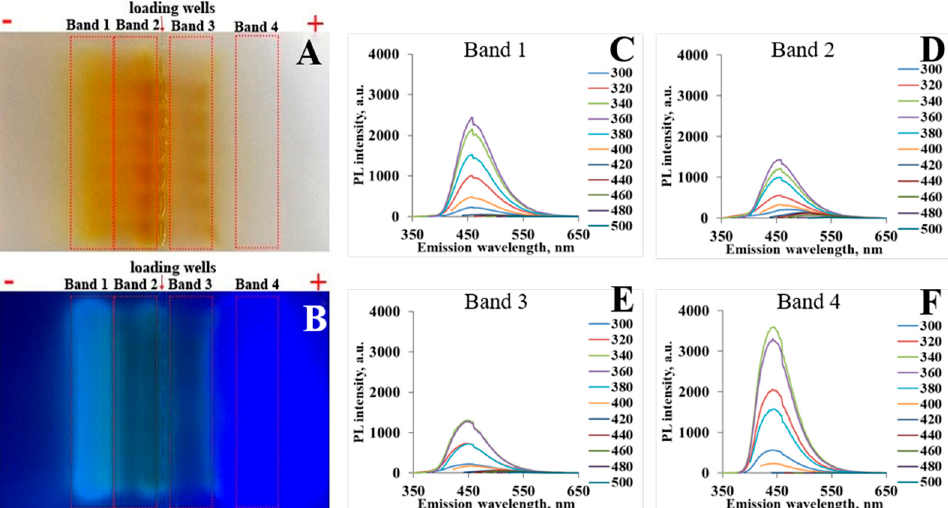
Figure 1. Gel electrophoresis separation of carbon nanoparticles (CNPs), hydrothermally obtained from citric acid (CA), and 1,2-ethylenediamine (EDA) at white light ( A ), and UV-light ( B ). Luminescent spectra of extracted bands 1 ( C ), 2 ( D ), 3 ( E ), and 4 ( F ). (Reprinted with permission from Reference [7], Copyright (2019)